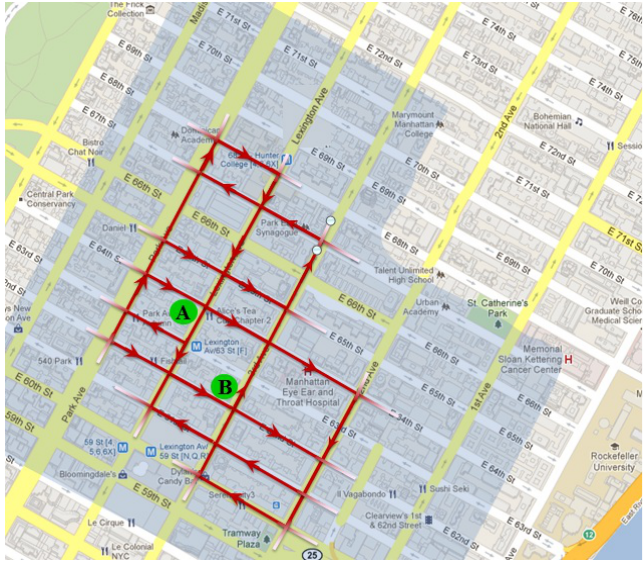
Figure 2. Illustrating a typical urban area prone to